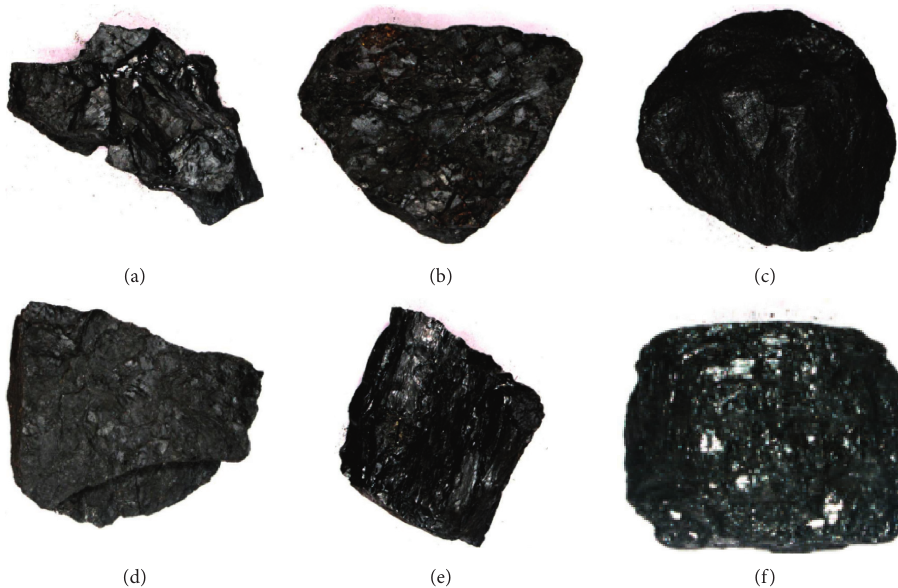
Figure 2: Image acquisition of different types of coal. (a) Fat coal sample. (b) Lignitous coal sample. (c) Coking coal sample. (d) Gas coal sample. (e) Gas fat coal sample. (f) Anthracite